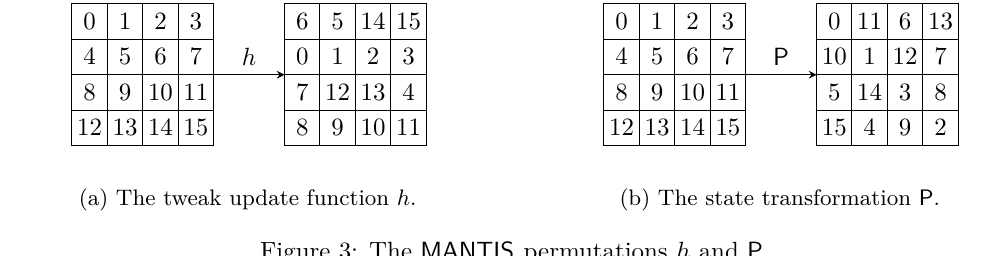
Figure 3: The MANTIS permutations h and P